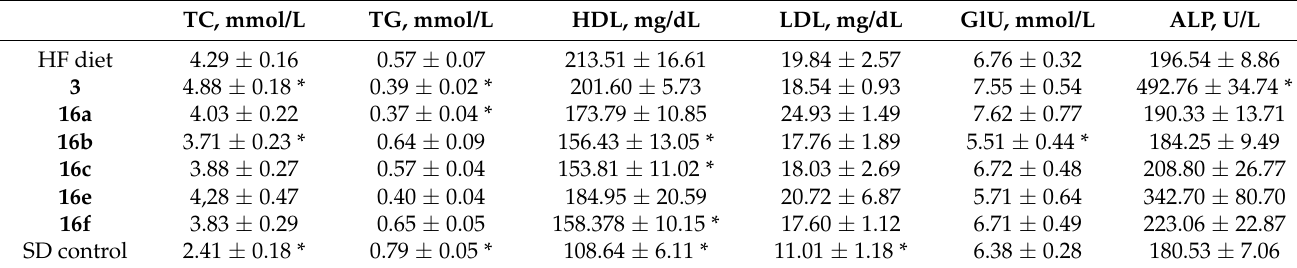
Figure 5. OGTT results. Area under glycemic curve (AUC). 16a–f were introduced at a dose of 30 mg/kg. * p < 0.05 compare to HF diet control. Table 1. Blood biochemical parameters at the end of the experiment (36 days).